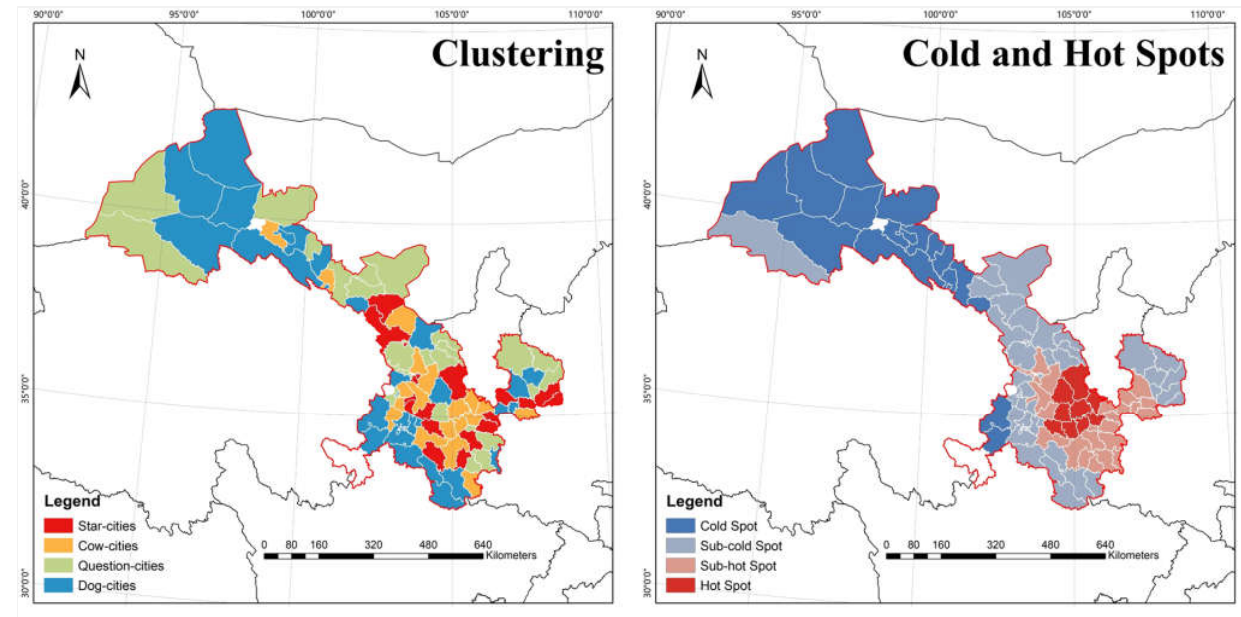
Figure 8. Spatial analysis on economic contribution of real estate in Gansu.